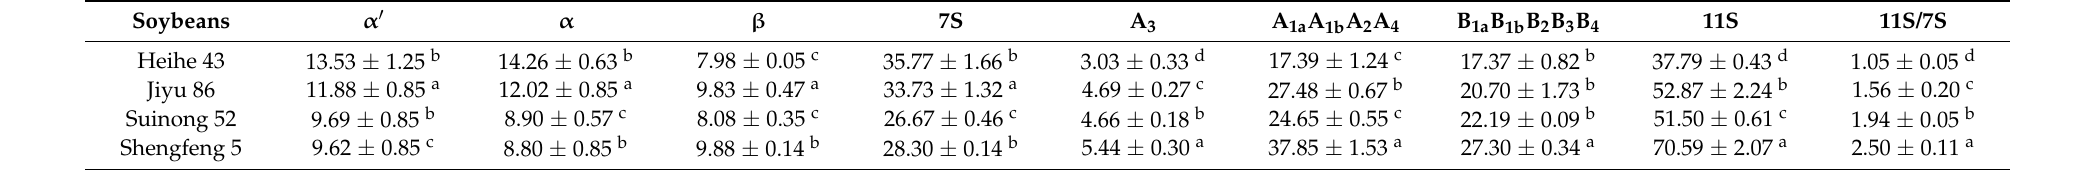
Different lowercase letters indicate a significant difference ( p <